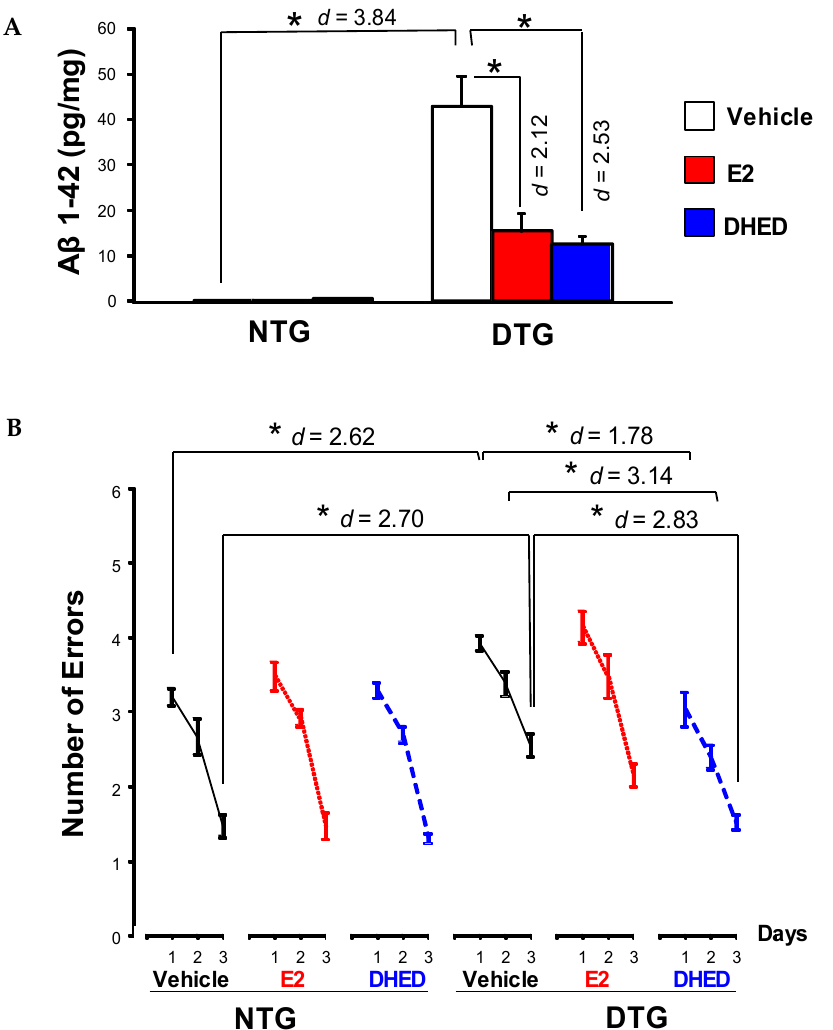
Figure 7. Evaluation of DHED treatment (8 weeks at 2 µg/day s.c., continuously by ALZET osmotic pumps) in males using the APPswe/PS1dE9 DTG (DTG) mouse model of AD. ( A ) A β 1–42 peptide levels in the brain of male non-transgenic (NTG) and DTG mice after treatment with vehicle, E2 (also 8 weeks at 2 µg/day s.c., continuously by ALZET osmotic pumps) and DHED; * p < 0.05 by ANOVA followed by post hoc Tukey’s honestly significant difference test, effect sizes indicated by Cohen’s d values. ( B ) Radial arm